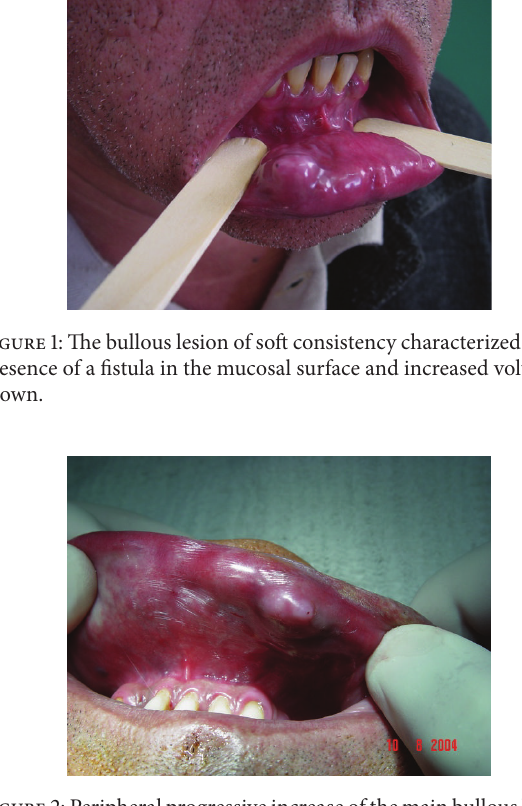
Figure 2: Peripheral progressive increase of the main bullous